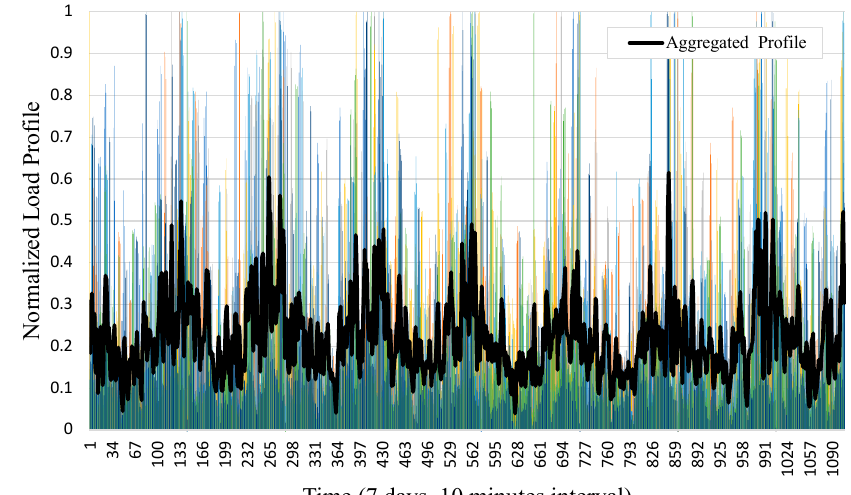
Figure 3. Normalized load profile of 149 households for 7 days in sequence.